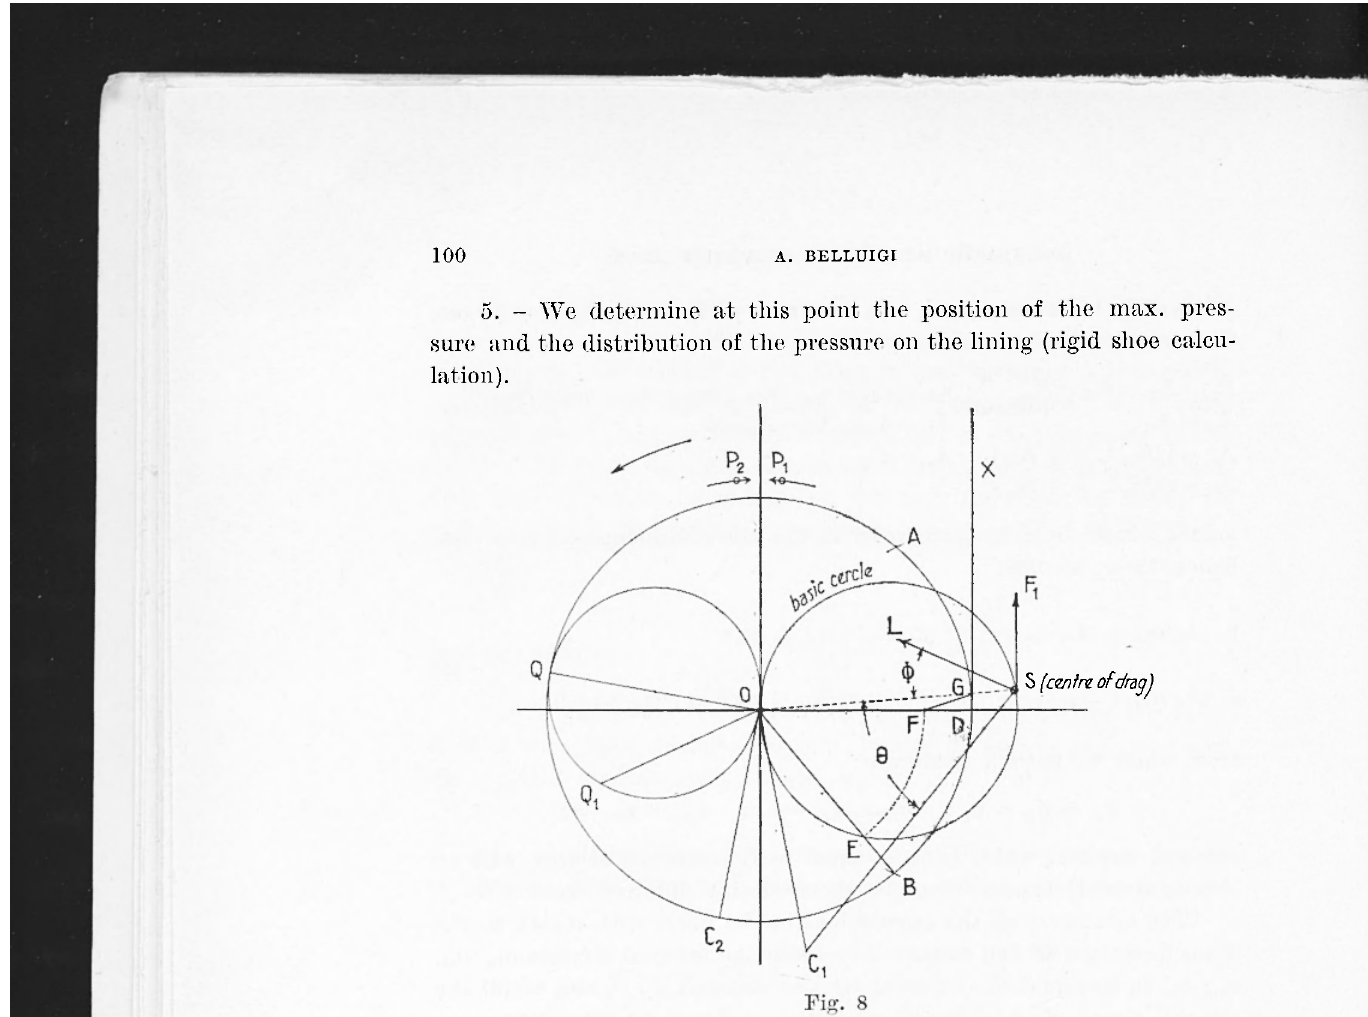
Tu Fig. 8, there is the " centre of drag ", point where act the résul- tant of the forces of the slioe on the drum s. The centre of the